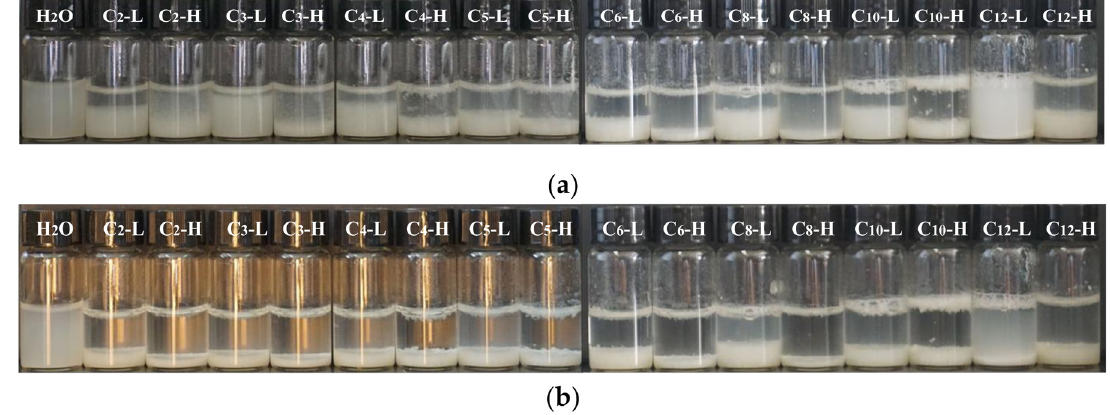
Figure 5. Flocculation performance of ILs at low (L, low concentration) and high (H, high concentration) concentrations after being added for: ( a ) 1 min; ( b ) 30